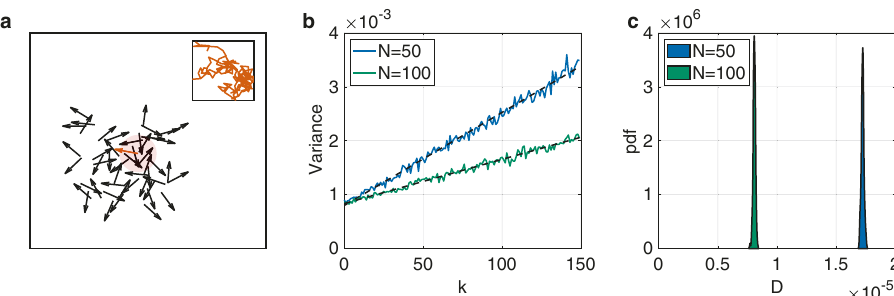
Fig. 1 Illustration of the proposed approach to infer the size of a collective of self-propelled Vicsek particles from the motion of a single unit. We perform 1000 repetitions where we record the heading of one particle in the collective for different values of the side length L of the square domain, speed s , number of particles N , and noise η . a Schematic of a numerical experiment for N = 20, where we display a time snapshot of the system (the focal particle is in red and its interaction circle is shaded). The inset depicts a sample trajectory of the focal particle evolving from the snapshot for 150 time steps. b Variance Y k of the heading of the focal particle as a function of time k for two system sizes when η = 0.1, s = 3, and L = 4, with the dashed black lines marking linear fi tting. Doubling the size halves the diffusion coef fi cient ( N = 50: D = 1.67 × 10 − 5 , and N = 100: D = 8.41 × 10 − 6 ). c Distribution of the diffusion coef fi cient as it would be estimated from observations of different focal particles in